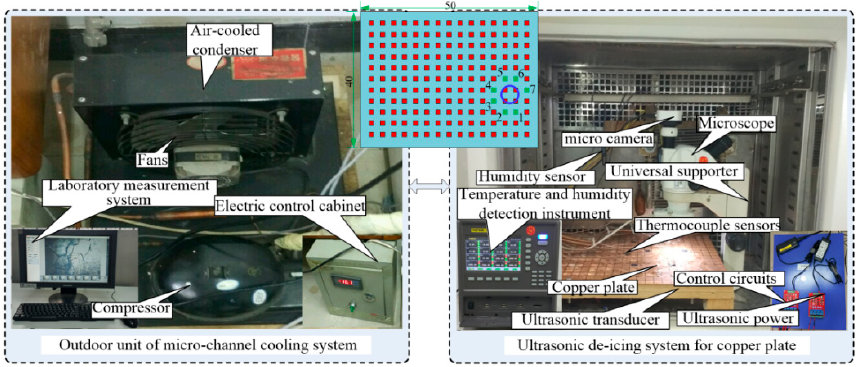
Figure 3. Ultrasonic array focusing defrosting system installed in a programmable constant temperature and humidity cabinet.